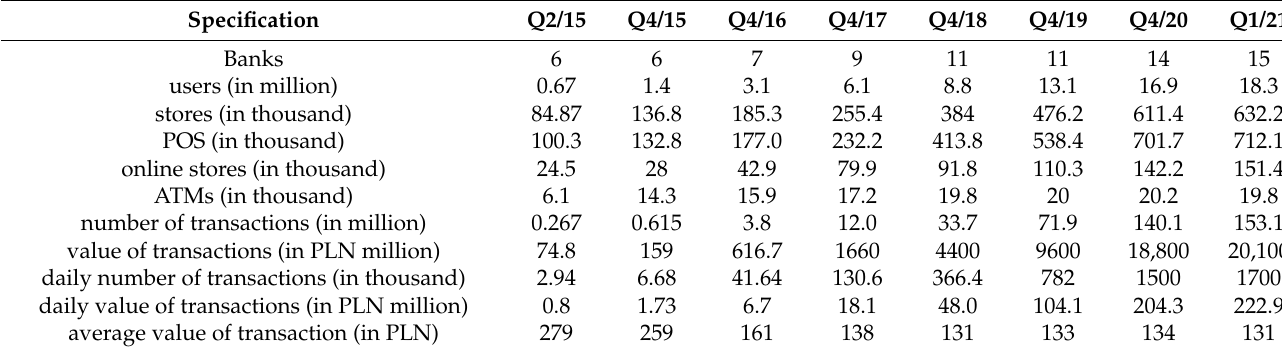
Table 8. Market data for BLIK